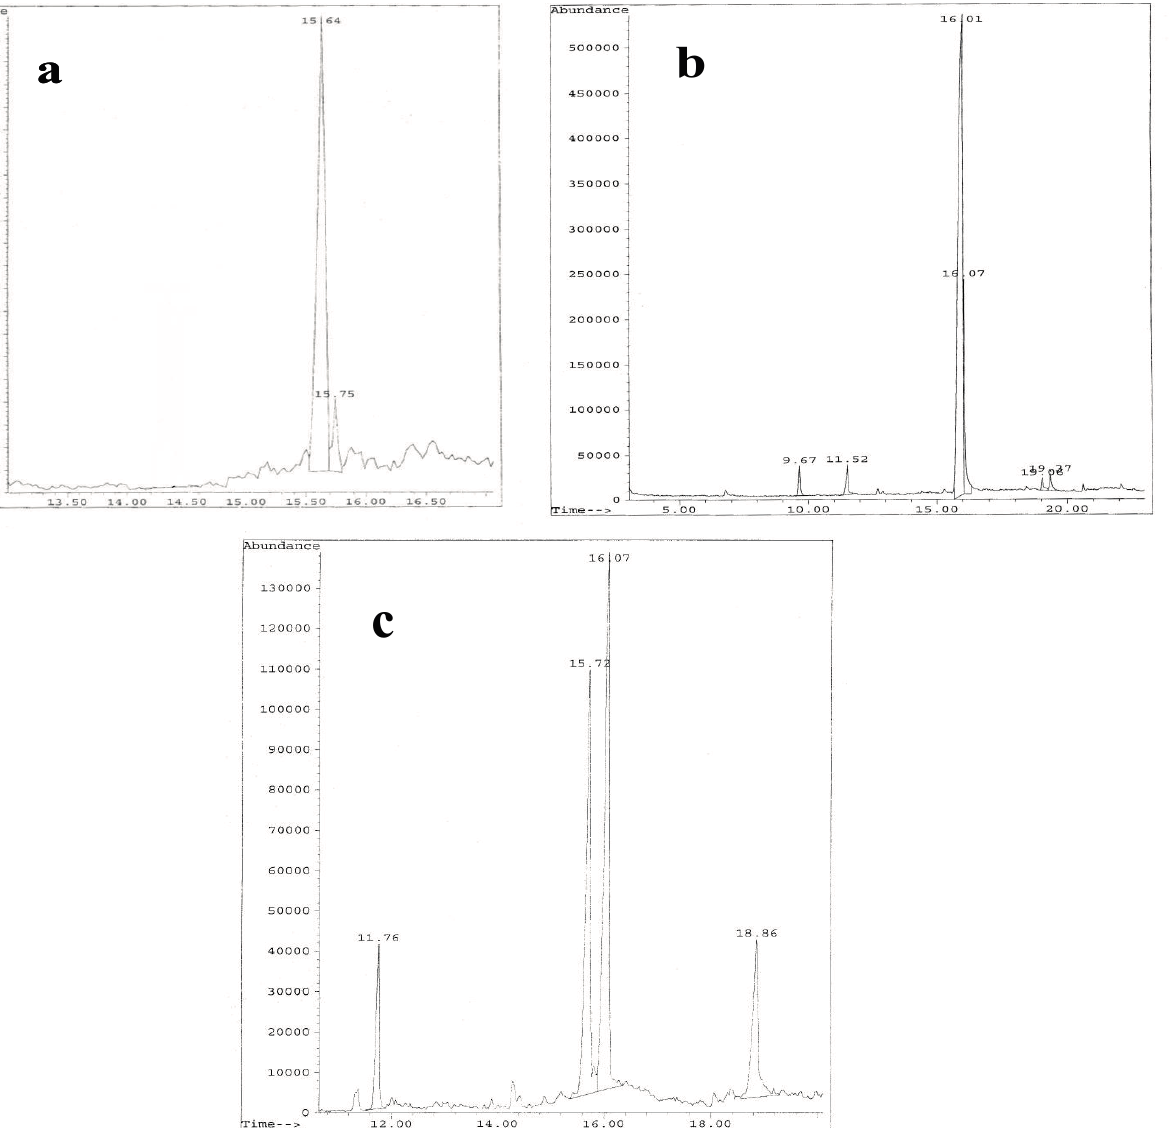
Figure 3. GC-MS of hydrolysed EPSs fractions produced by Bacillus licheniformis strain B3-15 ( a ); Geobacillus thermodenitrificans strain B3-72 ( b ); Bacillus licheniformis strain T14 ( c